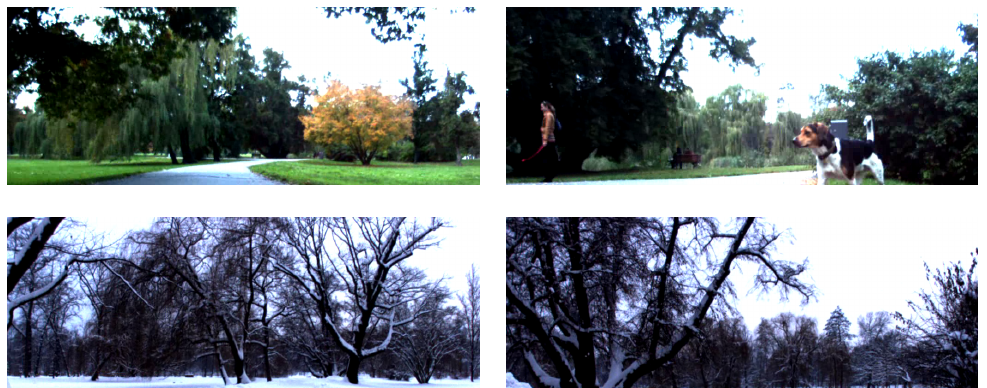
Figure 5. Images of different parts of the Stromovka dataset taken by the robot from the same place for each column.